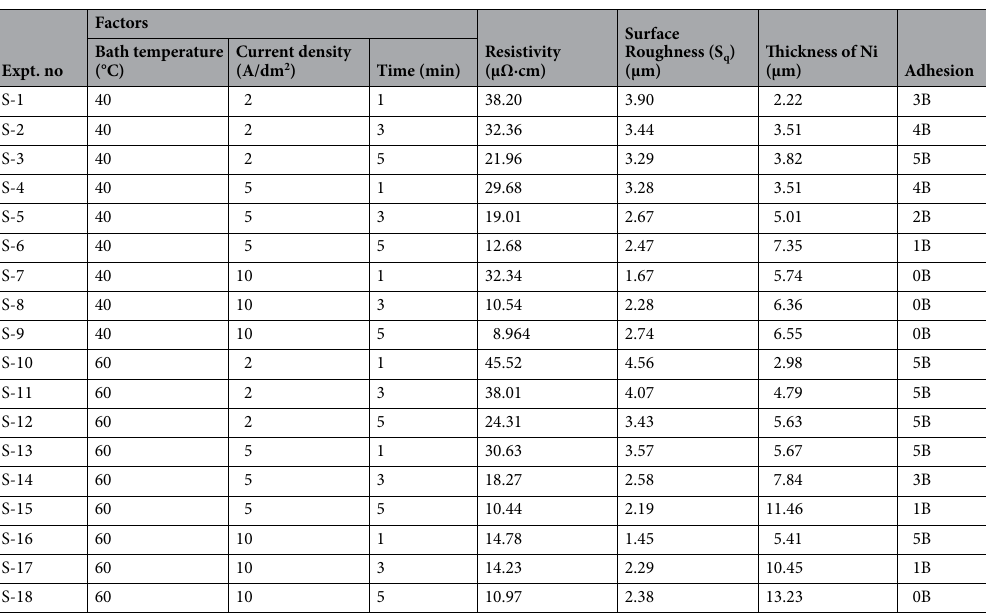
Table 8. Experimental results of Ni electroplating parameters on: resistivity, surface roughness, thickness, and adhesion.